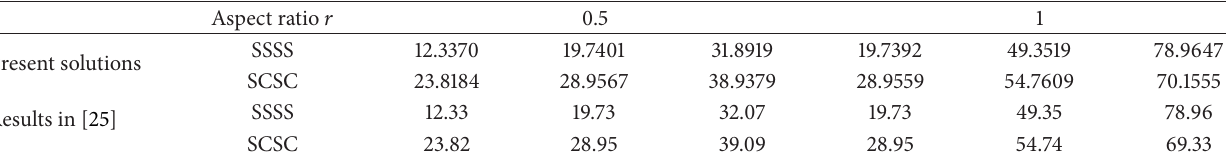
Table 1: The first three-order natural frequencies of the uniform thickness elastic plate with different boundary conditions.